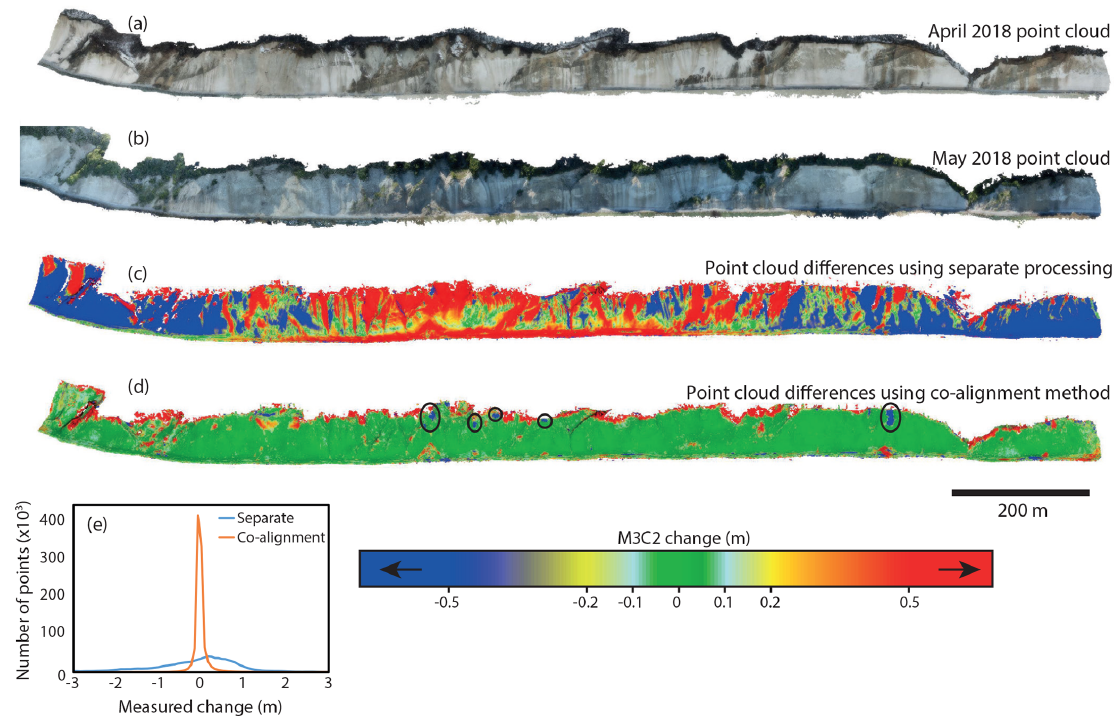
Figure 4. Cloud–cloud differences between the April 2018 and May 2018 surveys in the Kieler Bach section of the coast, calculated using the M3C2 algorithm. (a) April 2018 point cloud. (b) May 2018 point cloud. (c) M3C2 differences between point clouds created using the standard workflow. (d) M3C2 differences between point clouds created using the co-alignment workflow. High values of positive change at the top of the cliff are due to leaf growth on the trees. Isolated sections of positive change on the cliff face are also related to growth of bushes and trees. In panel (d) , several small failure events can be identified on the cliff face (circled). These have been confirmed visually using the before and after photographs. (e) Density curves of the measured changes shown in panels (c) and (d)